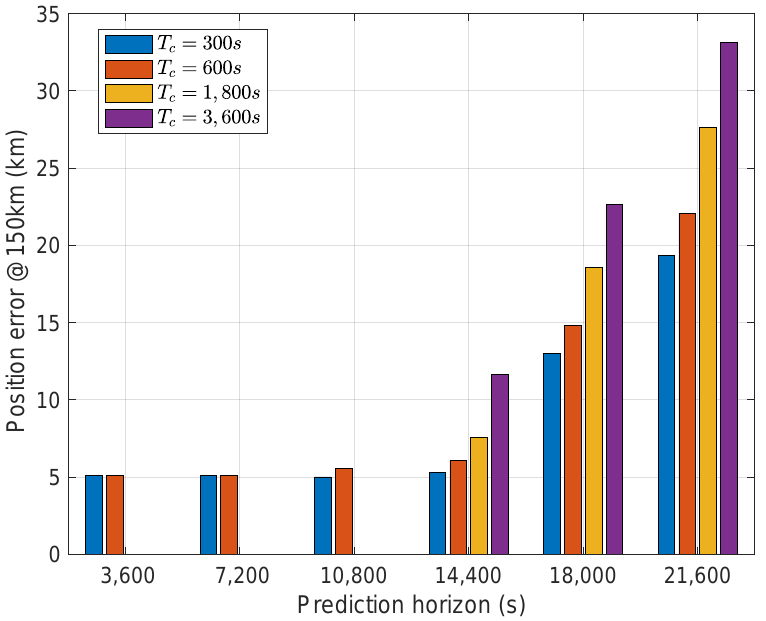
Figure 4. Sensitivity analysis on prediction horizon T p and controller sample time T c . Position error at the altitude of 150 km, before atmospheric